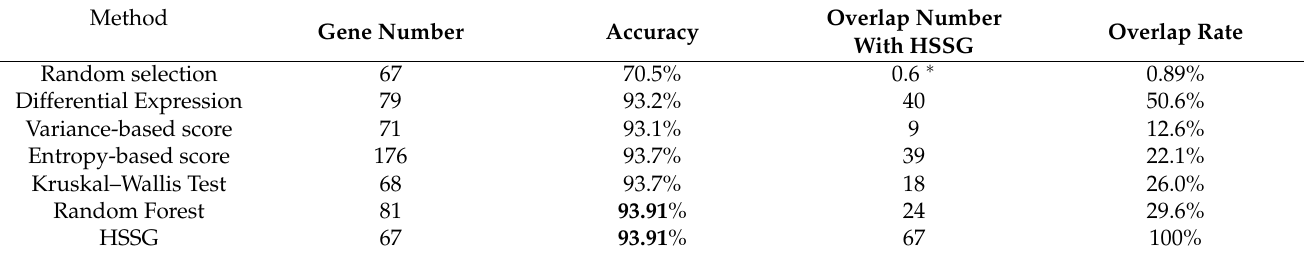
Table 4. Overlap of the six popular methods with the genes selected by the HSSG.